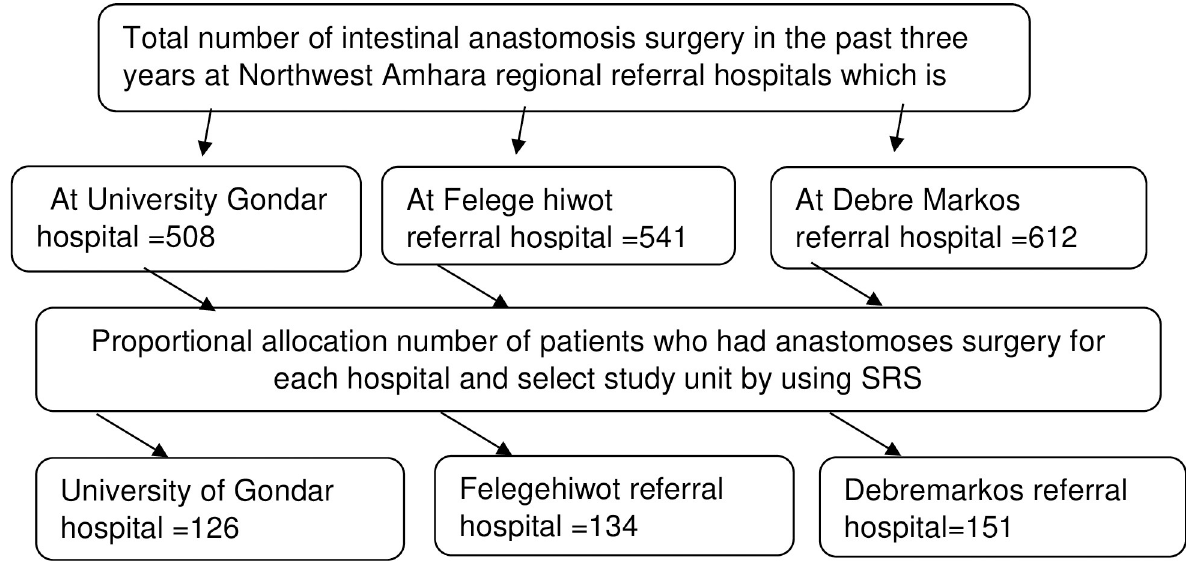
Fig 1. Schematic presentation of the sampling